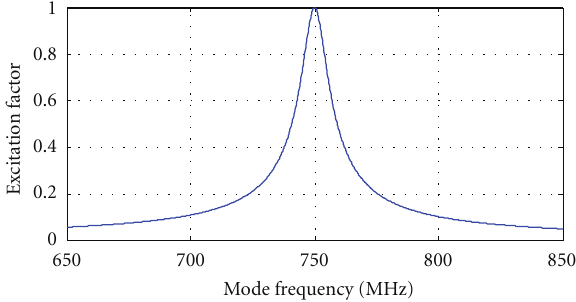
Figure 9: Normalized magnitude of the excitation factor as function of mode frequency for a 750MHz driving signal and a 30ns RMS delay. Only modes in a “3dB” region near the peak get e ff ectively